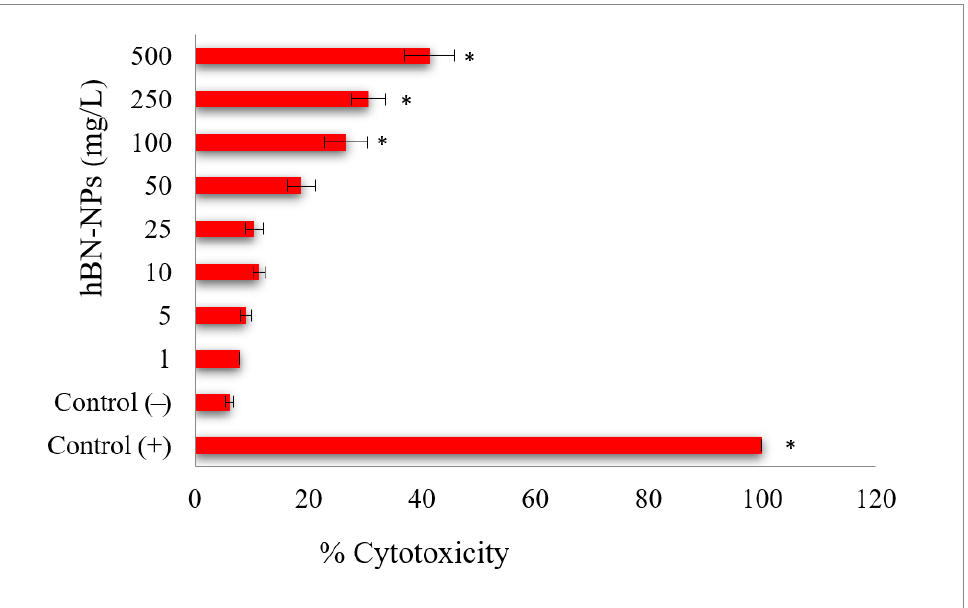
Figure 6. Cell viability (LDH assay) in differentiated SH-SY5Y cell cultures maintained 48 h in the presence of hBN-NPs. (Control ( − ): Cells without hBN-NPs; Control (+): Cell treated with Triton-X. * Symbol presents significant differences at the p < 0.05 level from the control group).